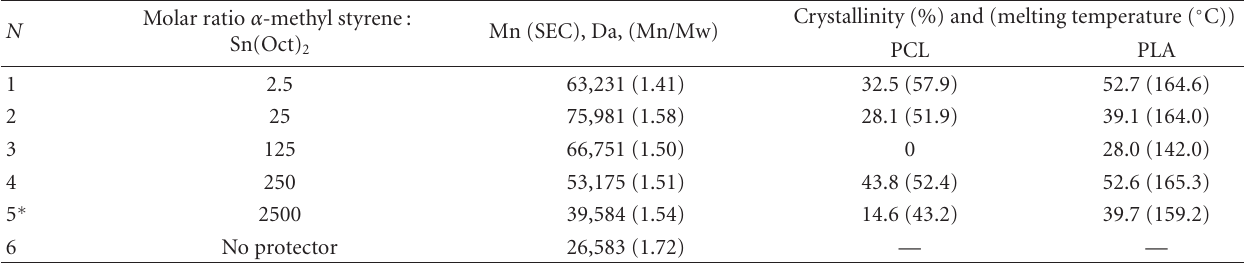
Table 2: Characteristics of triblock copolymers synthesised in the presence of α -methylstyrene.